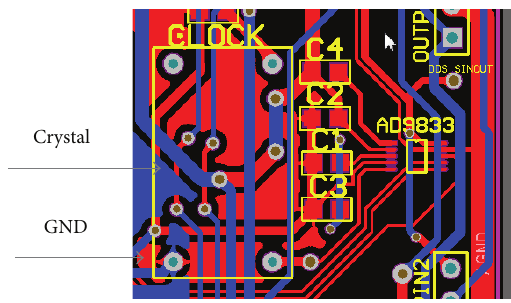
Figure 14: The PCB design diagram of AD9833.